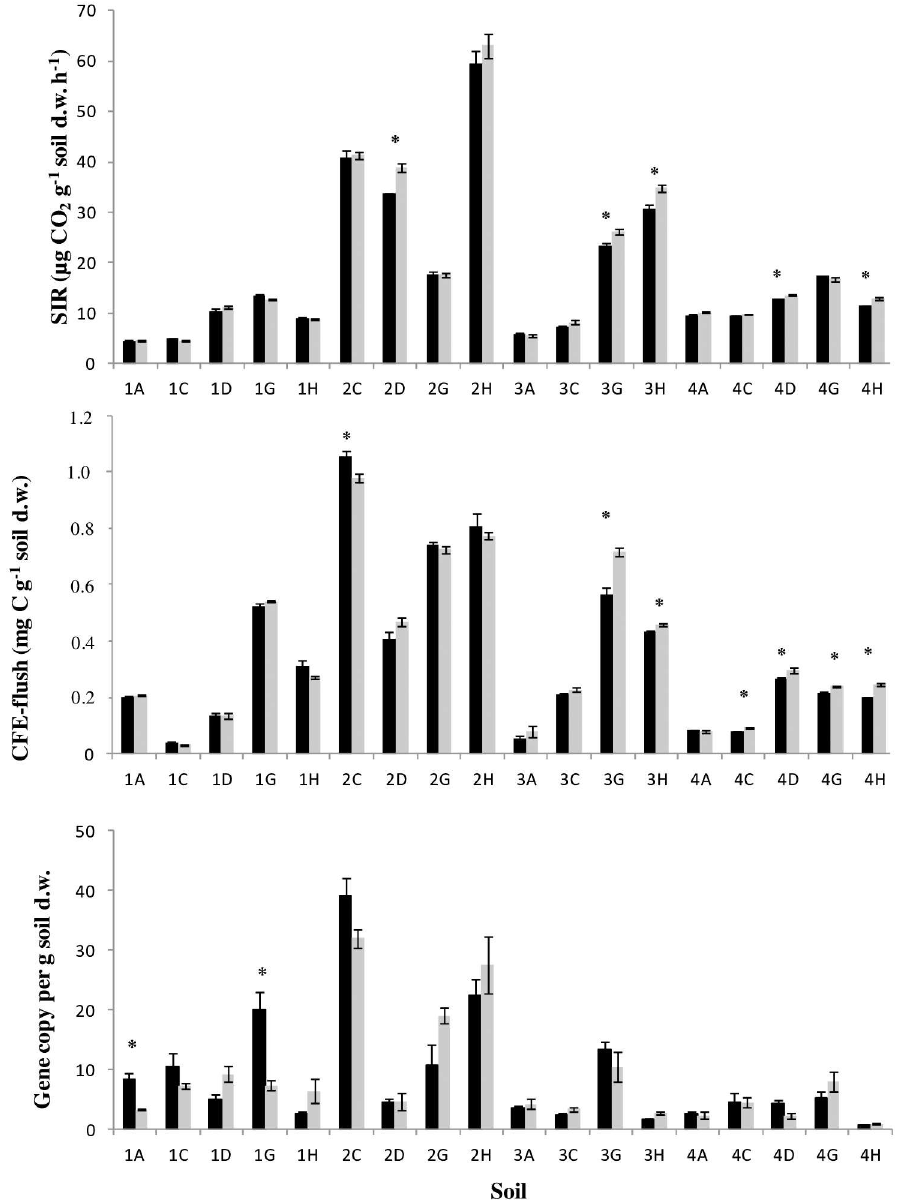
Fig 4. Microbial biomass estimated using a) SIR, b) CFE and c) qPCR methods and corrected for carbon loss in the control treatment (interpolated between pre-cooling and control treatment end of experiment biomasses, so that the MAT plus 3˚C soils were compared to the cooled (MAT minus 3˚C) soils at a similar C loss, corresponding to the maximum C loss of cooled samples at the end of the experiment. Each soil is identifiedby geographic/climatic area including1 (subarctic), 2 (Scotland), 3 (England), 4 (Mediterranean) and 5 (tropical), and ecosystem type: A (arable), C (coniferousevergreen forest), D (deciduousbroadleaf forest), G (grassland), H (ericaceous heath) and E (evergreen broadleaf forest) (21). Mean ± S.E. is presented (n = 3). Black bars (control treatment), grey bars (cooled treatment). Statistically significant differences ( P < 0.05) are marked with an